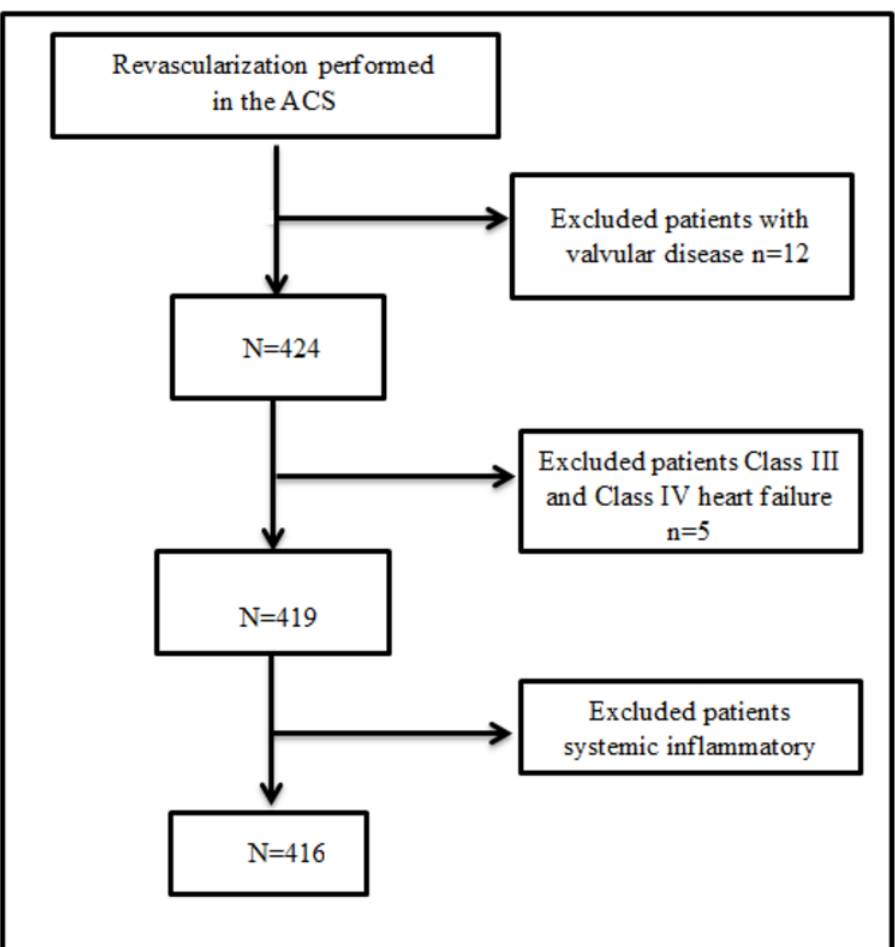
Fig 1. Flow chart of eligibility and exclusion of